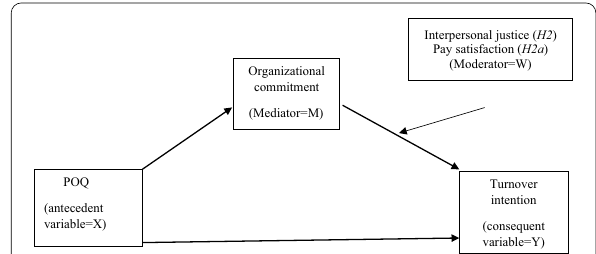
Fig. 1 Conceptual model for the mechanism through which POQ affects turnover intention (hypotheses 1, 2, 2a)